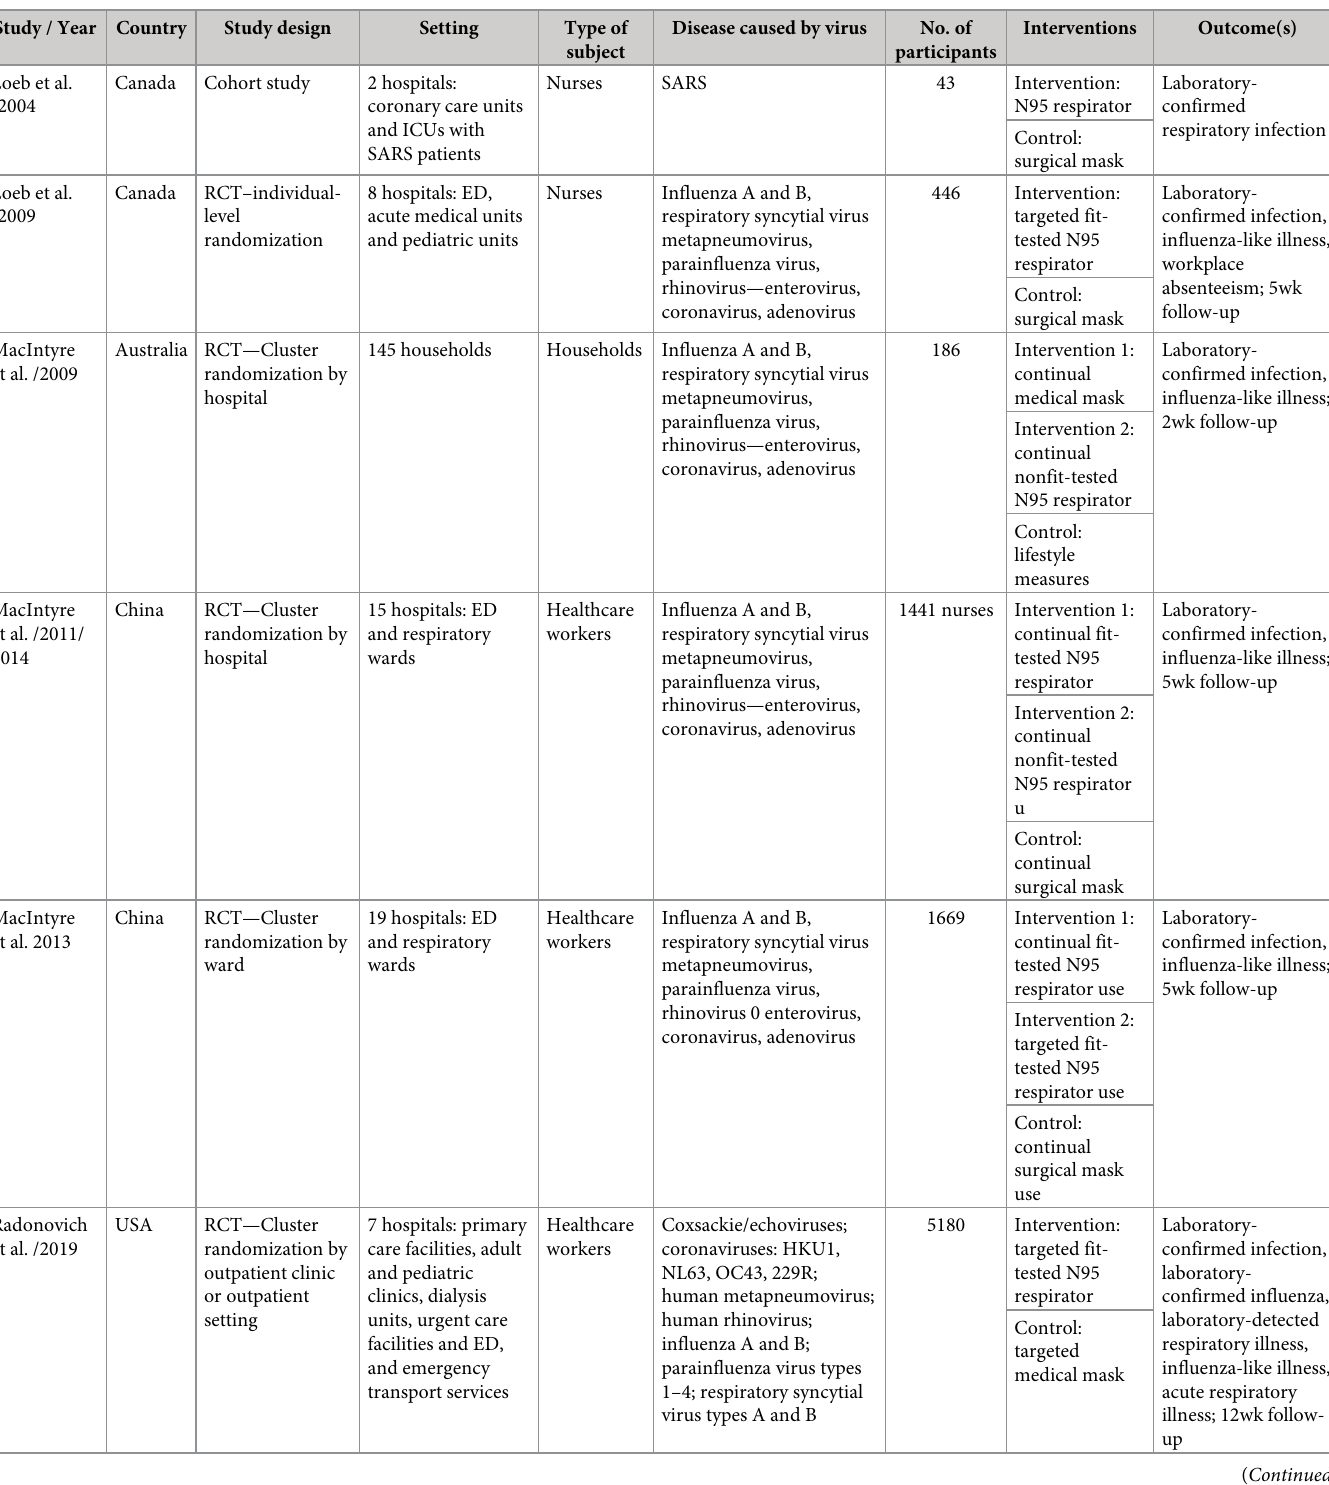
Table 1. Characteristics of included